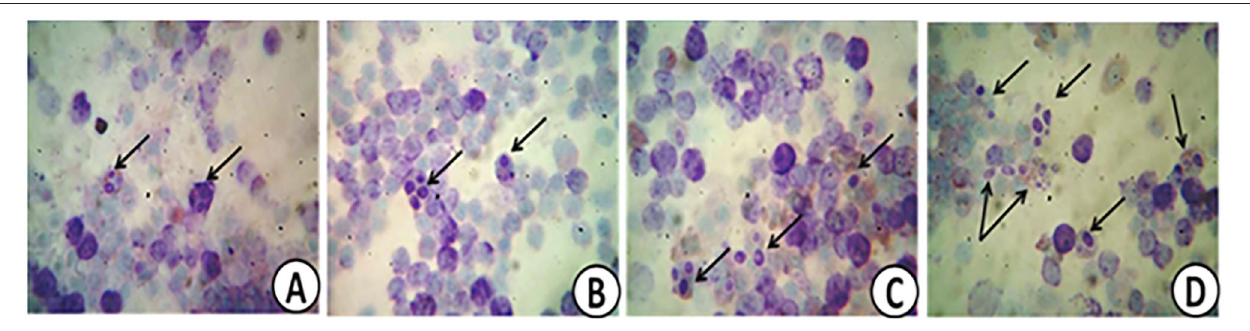
FIGURE 1 | Representative images showing normal (A) , mild (B) , moderate (C) , and marked (D) phagocytic activities in PROE0, PROE1, PROE2, and PROE3 treatments, respectively. (Ross and Cobb) and confirmed the positive effects of onion extract on the growth and blood parameters of both